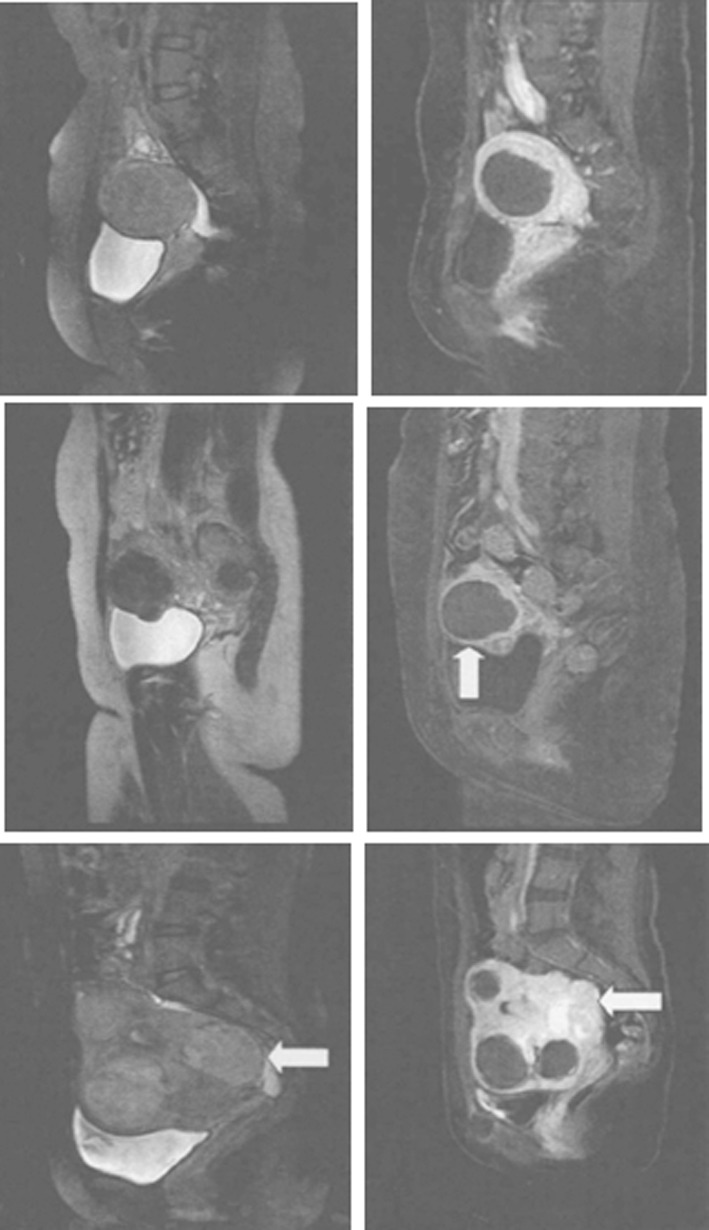
MRI images for different types of UFs. Left: Before HIFUA; right: after HIFUA. First row: intramural fibroid; second row: subserosal fibroid; third row:submucosal fibroid.